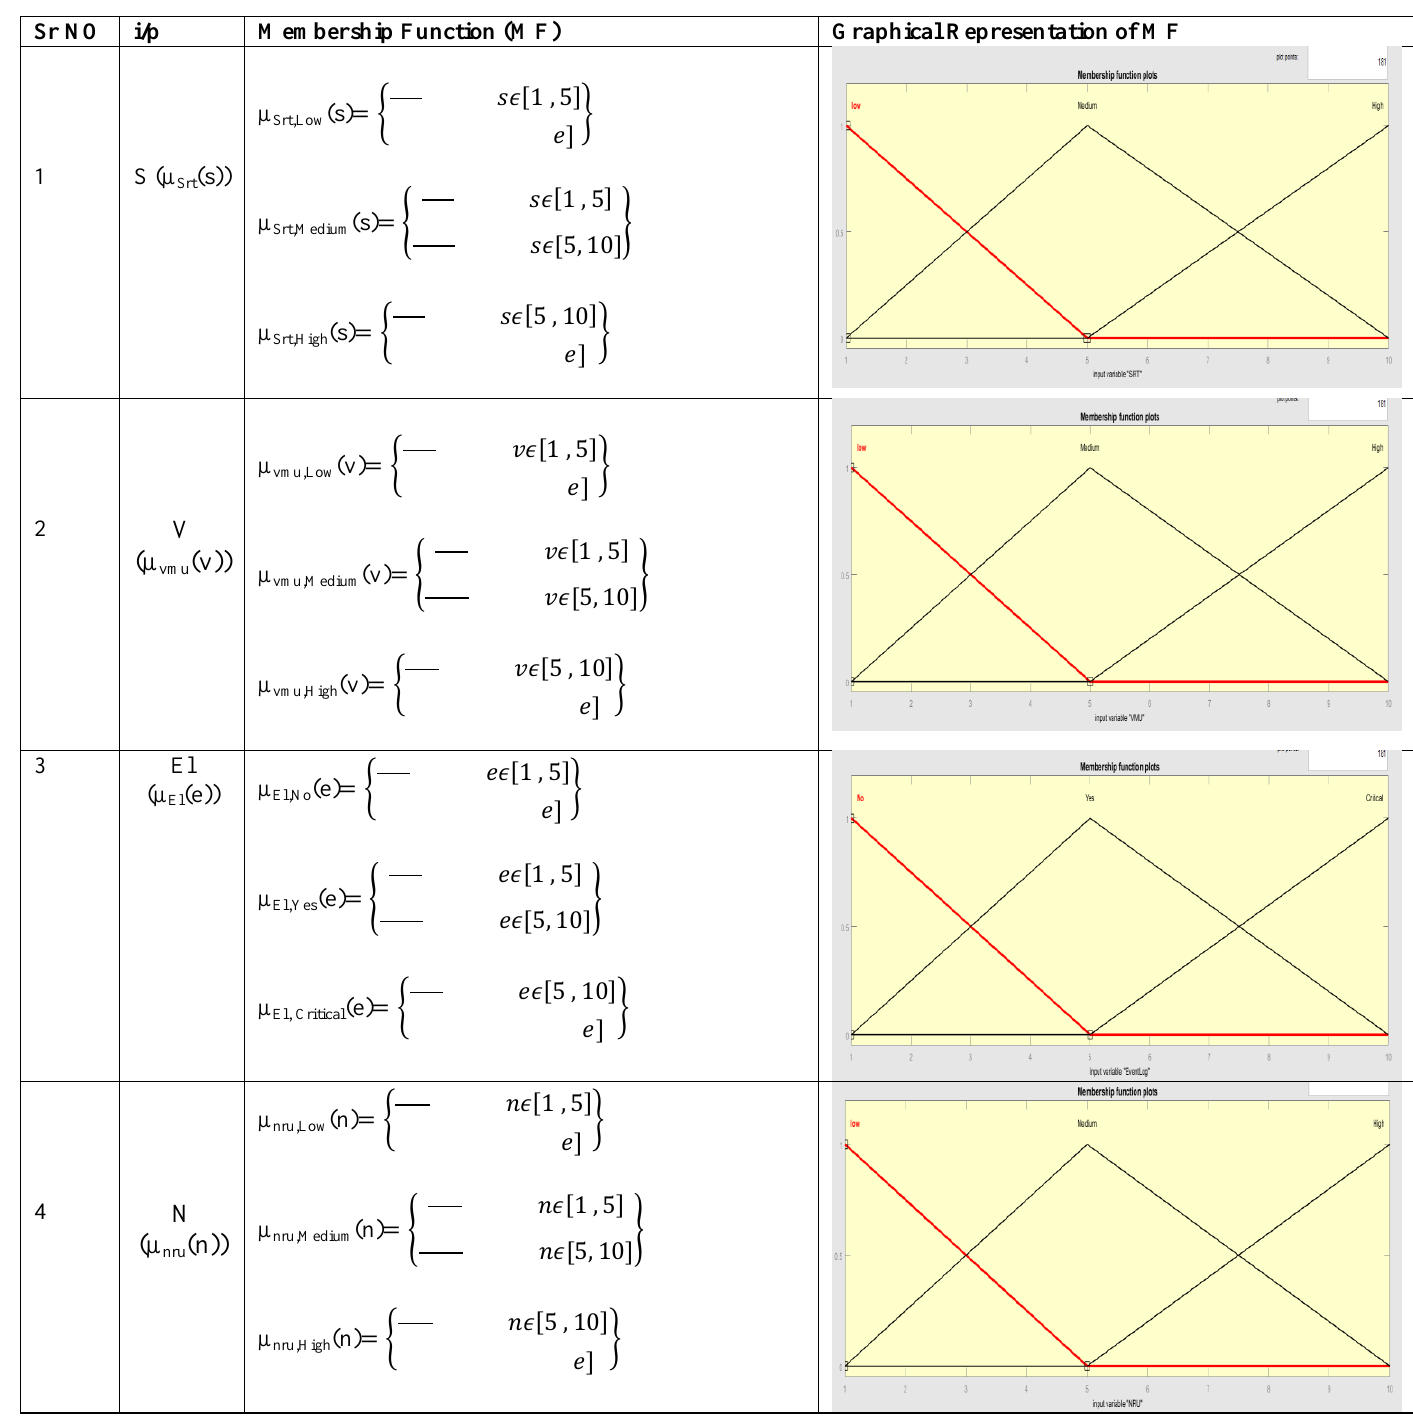
Table 7. Mathematical & Graphical MF of AFIS Input/output